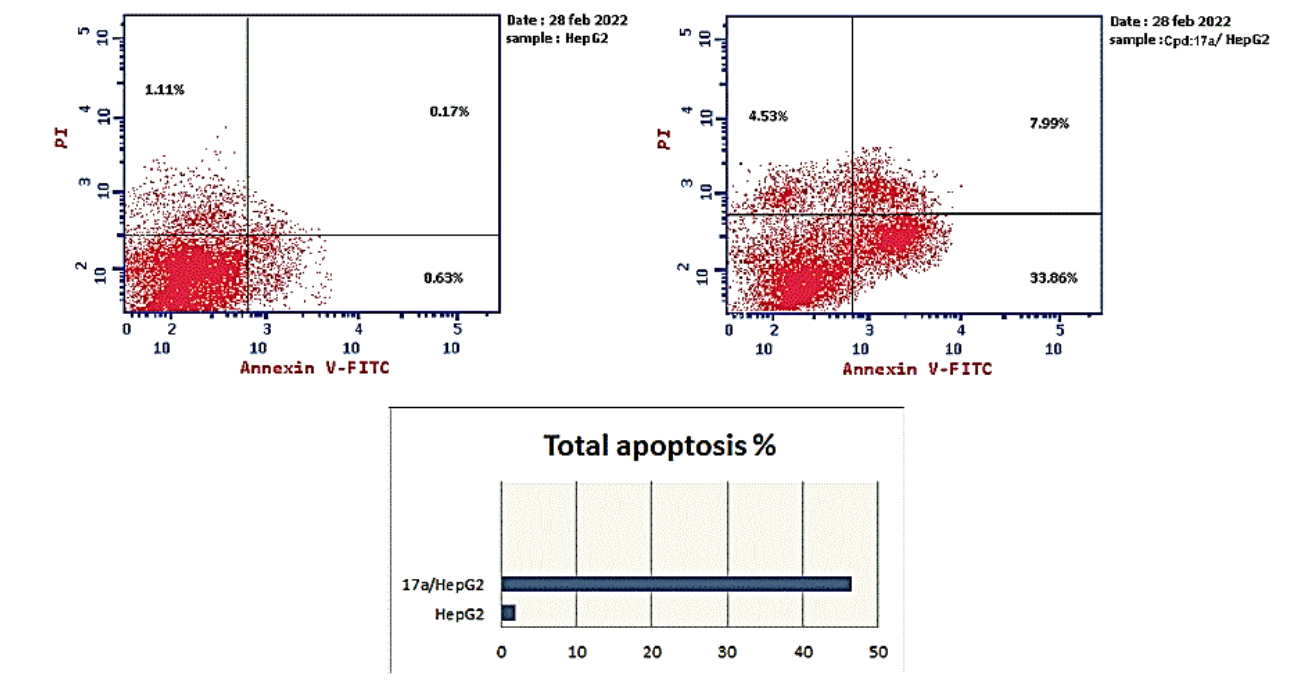
Figure 5. Apoptosis analysis of 17a using Annexin V-FITC/PI dual staining in HepG2 cells.